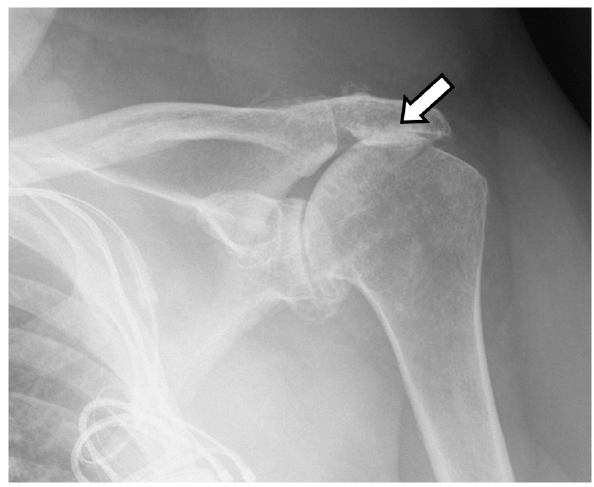
Figure 4. Frontal radiograph shows superior migration (white arrow) of the humeral head and developing acetabularization of the acromion in a patient with a full thickness rotator cuff tear.